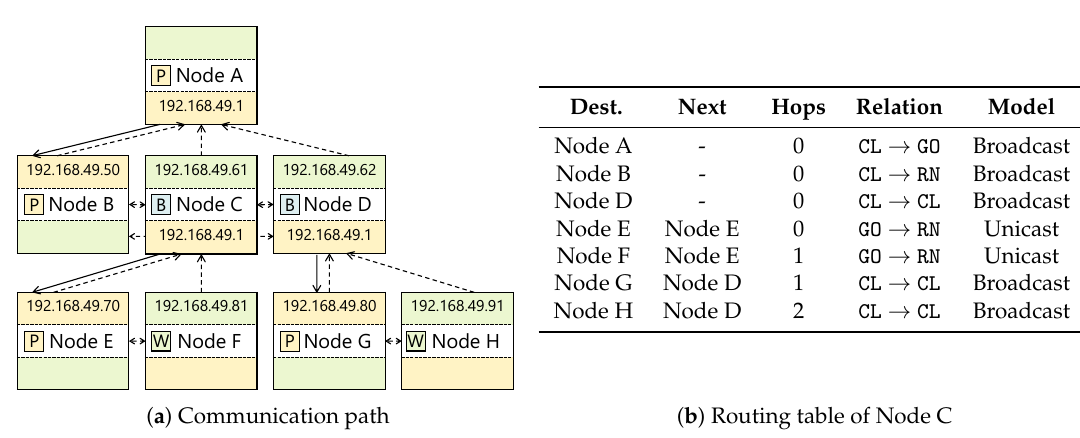
Figure 5. Routing table example: ( a ) The solid lines stand for unicast communication, and the dotted lines stand for broadcast communication; and ( b ) routing table of Node